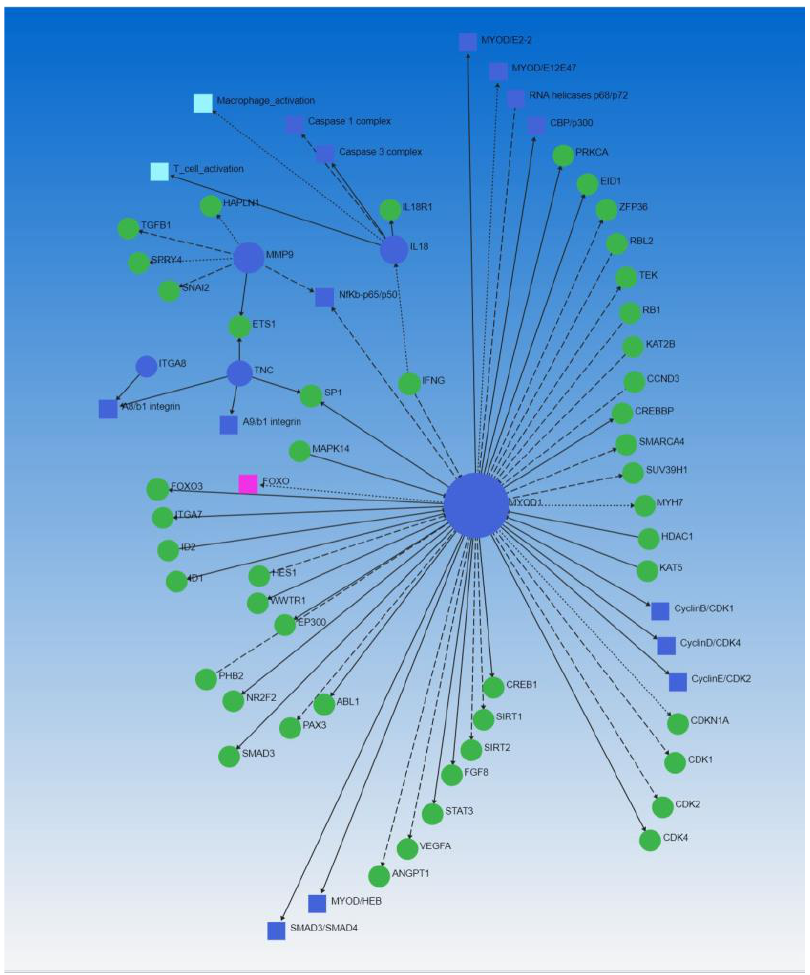
Figure 5. MYOD1 regulates the expression of various DEGs involved in chronic inflammation, plaque formation, and thrombosis.